Question: Which visualization type does this figure use?
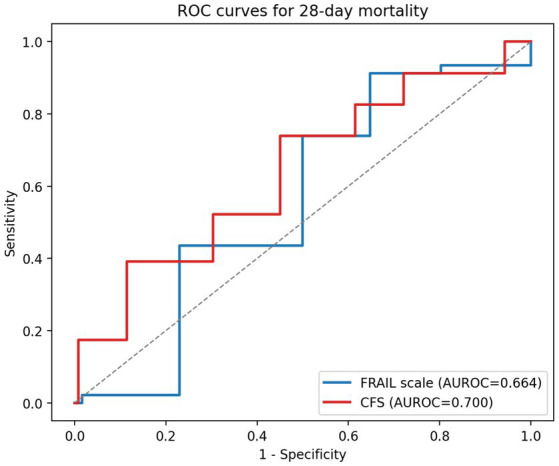
Answer: line